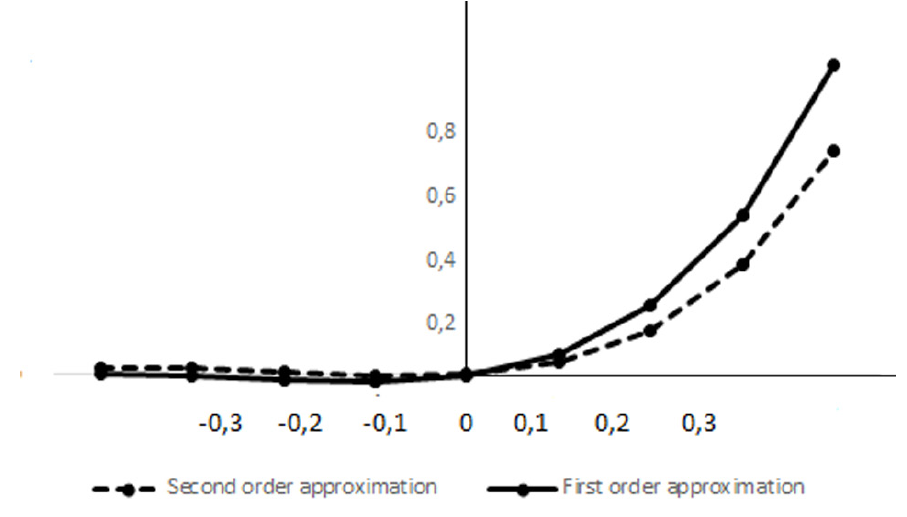
Figure 2. The yield curve of first and second order approximation, the Taylor series for the degenerate Heston